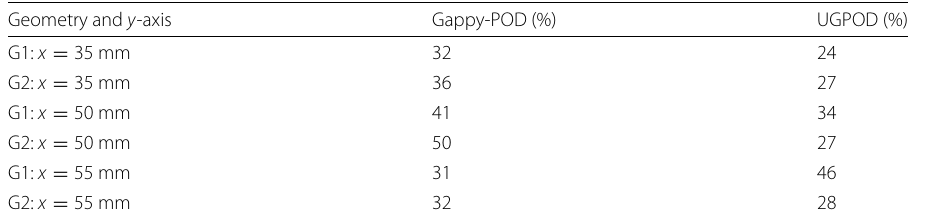
Table 1 Evaluation of the 1D L 2 -relative errors along the three y -axis respectively Geometry and y -axis